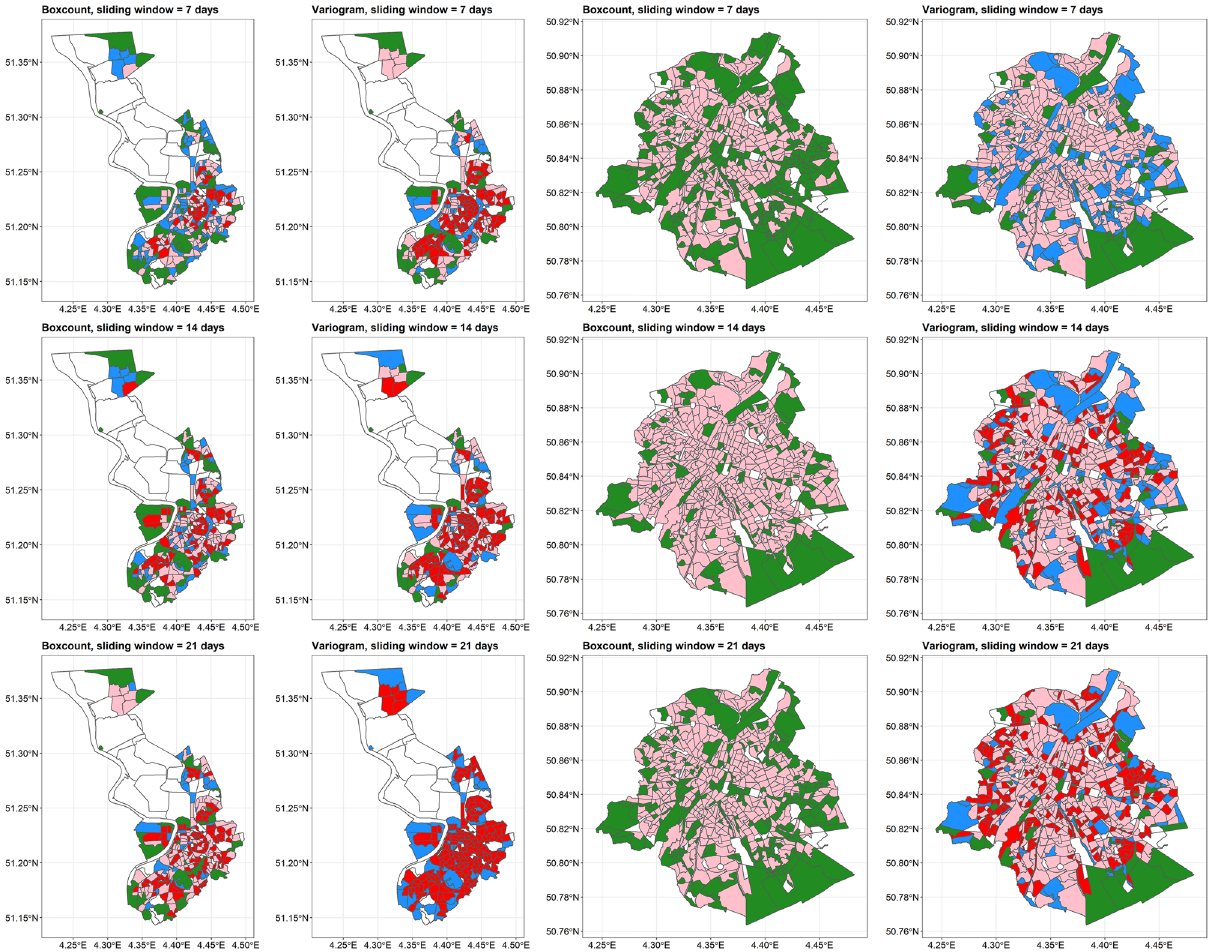
Figure 4. Classification of statistical sectors in Antwerp municipality (left panels) and Brussels Region (right panels) calculated by box-count and variogram estimator. The color green, blue, pink, and red correspond to mild sporadic, heavy sporadic, mild community, and heavy community, respectively. White color represents no reported cases. The map is adapted from https:// statb el. fgov. be/ en/ open- data/ stati stical- secto rs- 2020 using R 4.2.1 (https:// CRAN.R- proje ct.